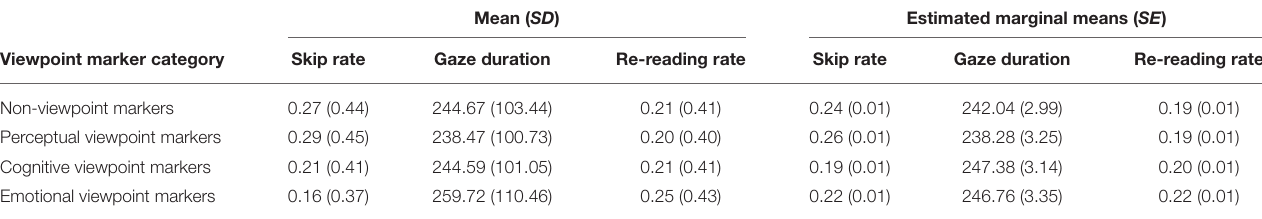
TABLE 3 | Descriptive statistics for the eye-tracking data by viewpoint marker